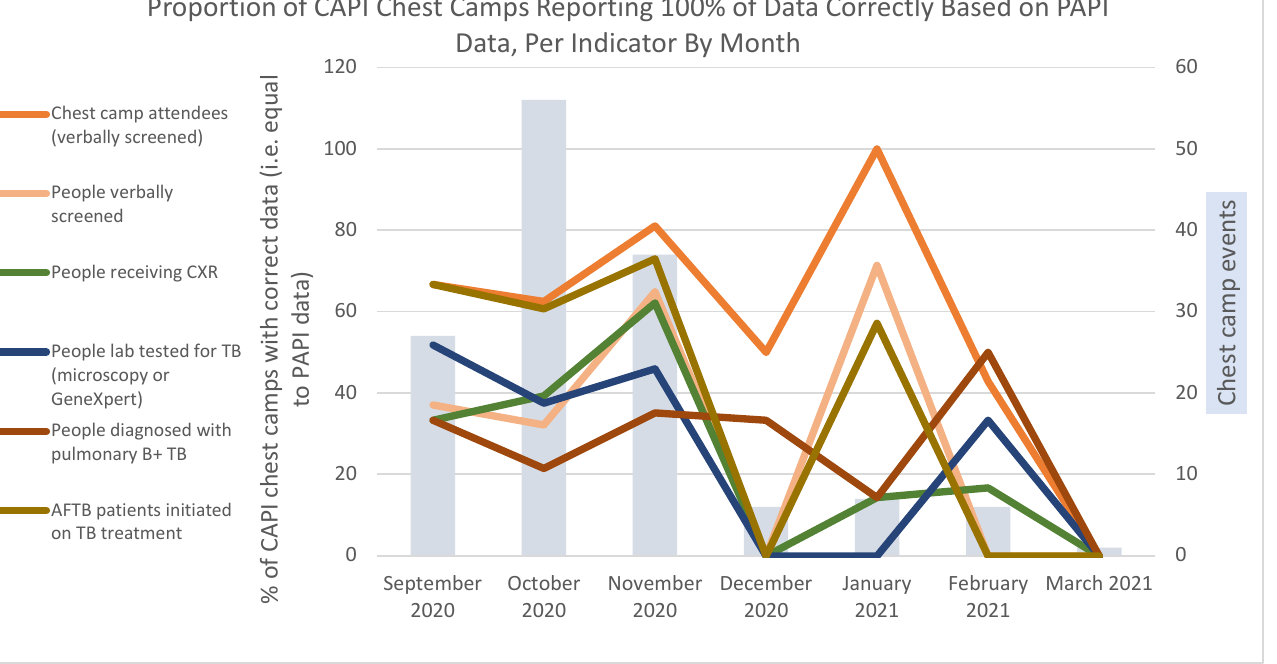
Figure 5. Proportion of CAPI chest camps reporting 100% of data correctly based on PAPI data, per indicator by month.